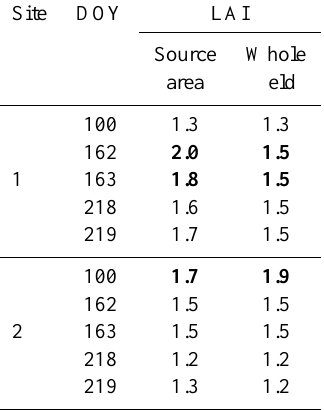
Table 7. Average leaf area index (LAI) estimated for the flux tower source area/flux footprint versus the whole field derived from the aircraft imagery (NDVI relationship with LAI). The LAI values in bold are associated with the days where differences in water con- sumption estimated by TSEB versus using the tower measured ET are significant for site 1 (northern vineyard) and site 2 (southern vineyard).